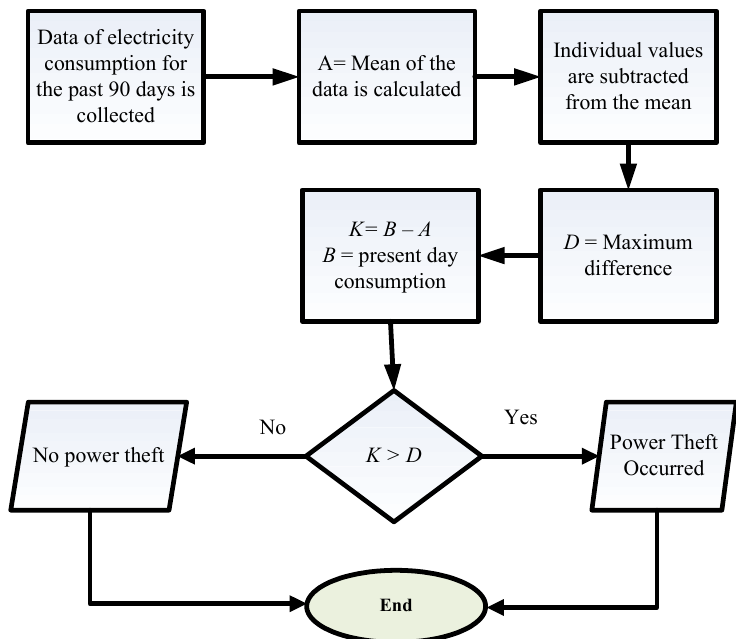
Figure 5. Flowchart of power theft detection procedure.